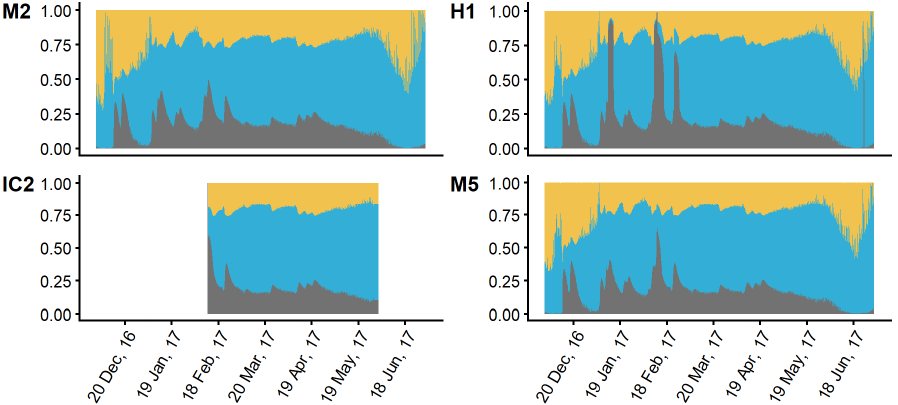
Figure 6. Source water fraction time series at four example locations (depicted in Figure 3) where all fractions add to 1.0. The yellow portion represents the Cosumnes tracer, the blue portion represents the Mokelumne tracer, and the grey represents the Other tracer. M2: Downstream of confluence. H1: Dead Horse Cut. IC2: Island site C2. M5: South Fork Mokelumne. Water 2020 , 12 , x FOR PEER REVIEW